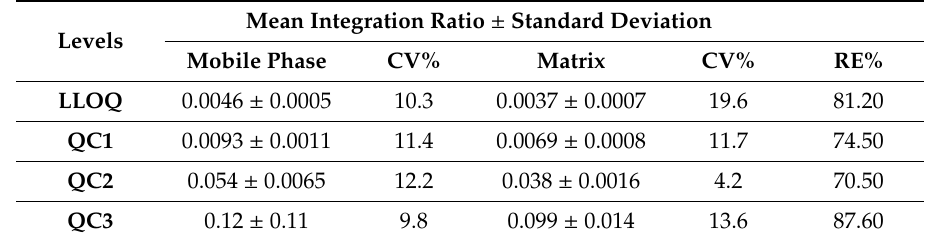
Table 3. Recovery values (RE%) for PTX at QCs and LOQ levels obtained through the validation